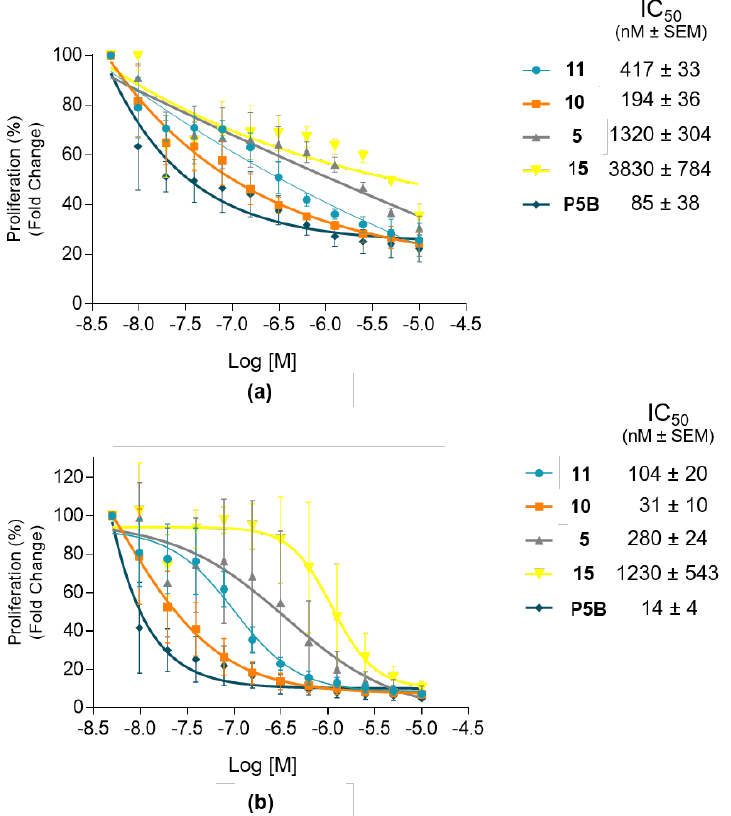
Figure 6. Concentration–response curves for antiproliferative activity of compounds 5 , 10 , 11 , 15 and reference P5B. ( a ) Antiproliferative activity and IC 50 values of selected compounds in A375 cell line; ( b ) Antiproliferative activity and IC 50 values of selected compounds in Colo205 cell line. Data are the mean ± SEM of three independent experiments run in triplicate.